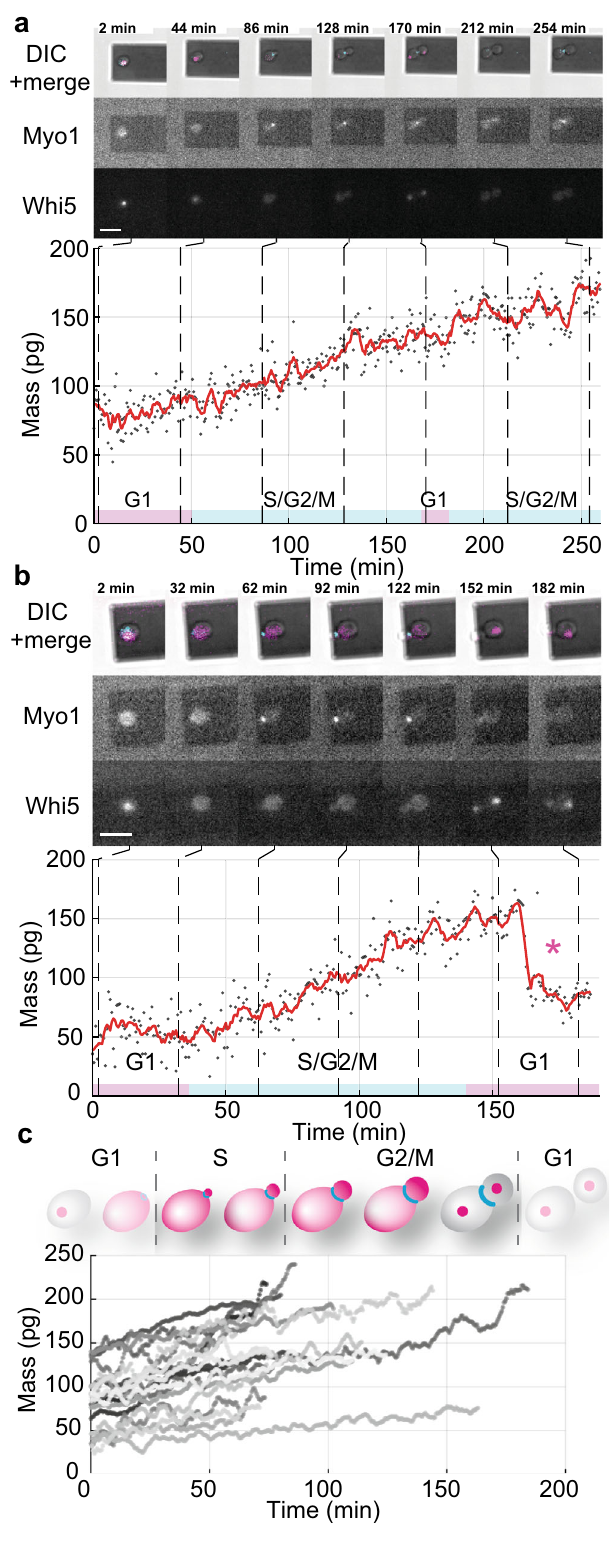
M phase, which highlights that individual yeast cells grow at different rates (Fig. 2c). This result is in agreement with previous fi ndings that single yeast cells spend different times to progress through cell cycle phases 17,51 – 56 . On average, the cells spent ≈ 94 min in the S/G2/M phase (Supplementary Fig. 4). For the